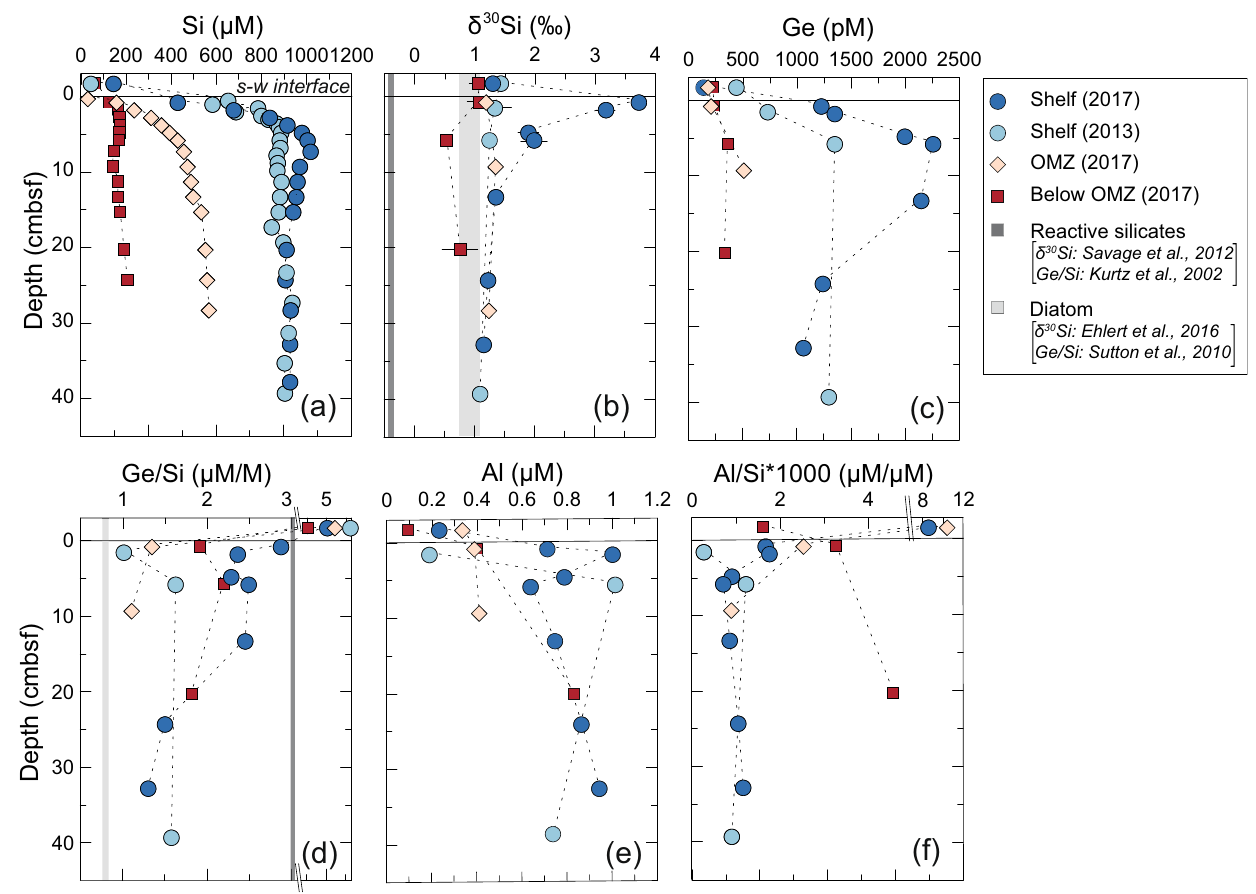
Fig. 2 | Geochemical variations at the Peruvian margin. a – f Pore water geo- chemistry, Ge/Si ratios, Al/Si ratios, and δ 30 Si values versus depth (centimetres belowsea fl oor; cmbsf). Black horizontal lines denote the sediment-water interface (s-w interface). Values above the s-w interface are measured in bottom water samples. OMZ labels the Oxygen Minimum Zone. Error bars (2 SD of individual